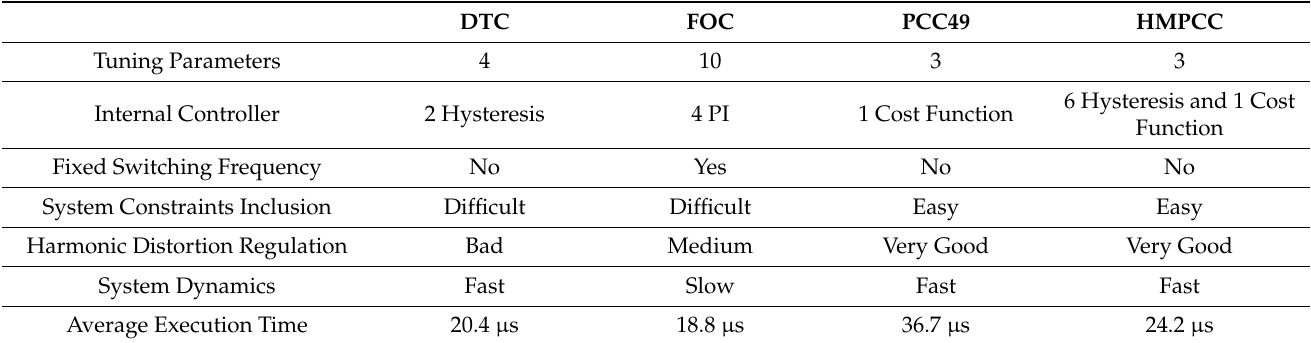
Table 2. Summary of the indicators for the classic control strategies and the proposed method applied to the asymmetrical six-phase IM. DTC FOC PCC49